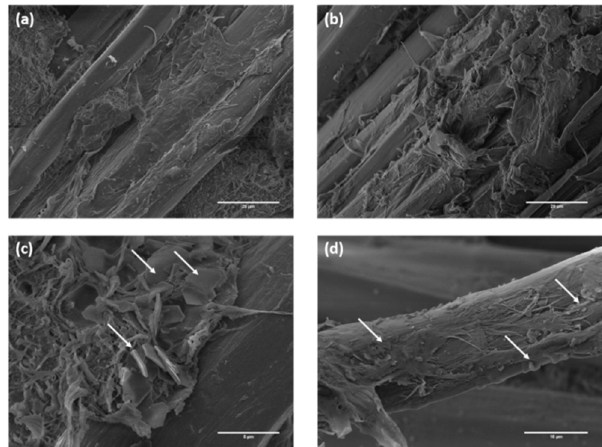
Figure 16. SEM micrographs of the fracture surfaces of PP/Flax_SA composites at different magnifications.